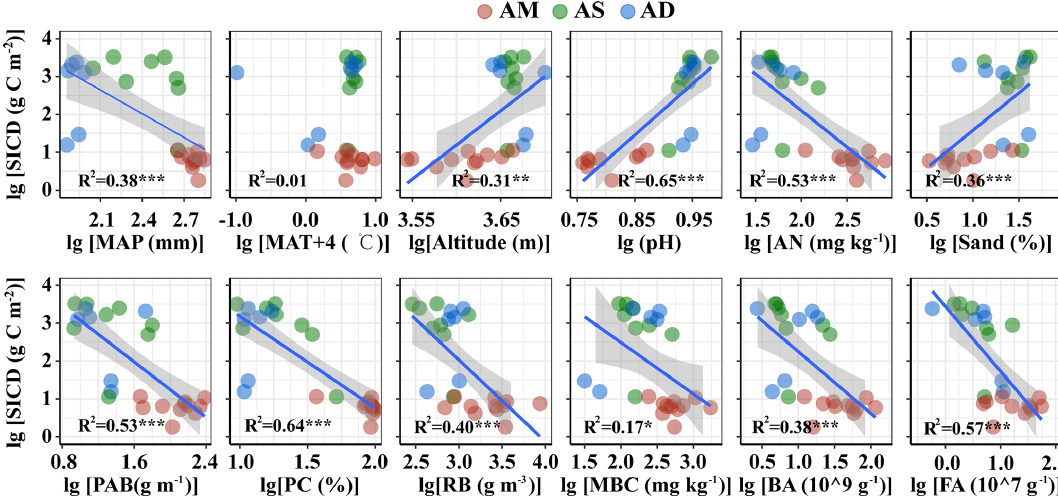
Figure 2. SIC density in relation to climatic, edaphic, plant and microbial factors in the topsoil. The solid lines are fitted by ordinary least- squares regressions, and the shadow areas correspond to 95% confidence intervals. AM: alpine meadow; AS: alpine steppe; AD: alpine desert; MAP: mean annual precipitation; PAB: plant aboveground biomass; PC: plant coverage. The abbreviations for other variables are shown in Table 1. ∗ p < 0 . 05; ∗∗ p < 0 . 01; ∗∗∗ p < 0 . 001.